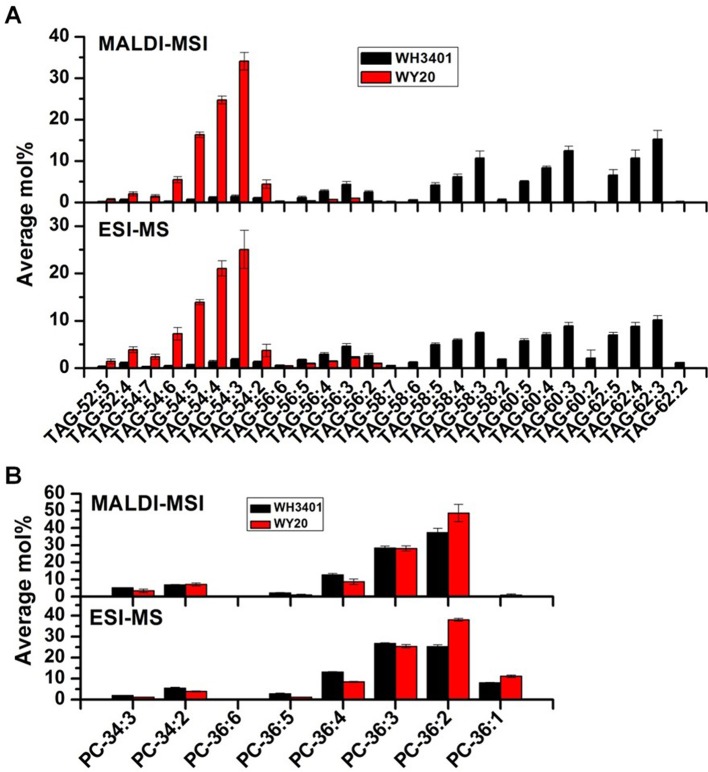
Comparison of the relative levels of triacylglycerol (TAG) and phosphatidylcholine (PC) species in mature seeds measured by MADLI-MSI (mol% from ion intensities summed over the entire section) and ESI-MS of whole-seed extracts using tri-17:0 TAG and di-14:0 PC as a quantitative standard. (A) TAG species. (B) PC species. Data are the means ± SD of 3 biological replicates.